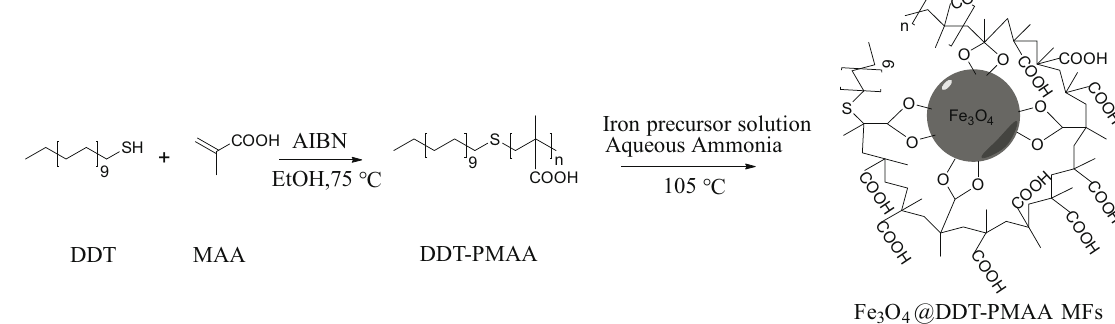
Scheme 1: Schematic illustration of the preparation of DDT - PMAA - modi fi ed Fe 3 O 4